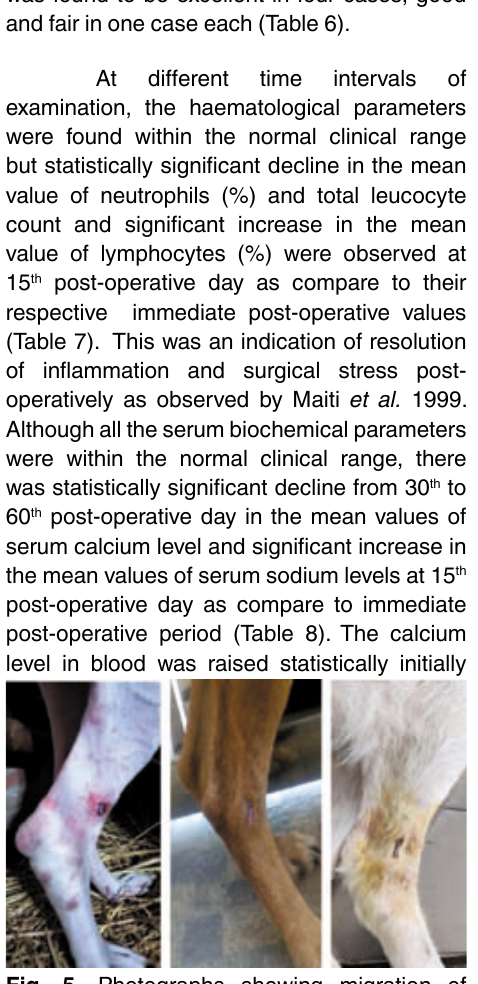
Fig. 5. Photographs showing migration of